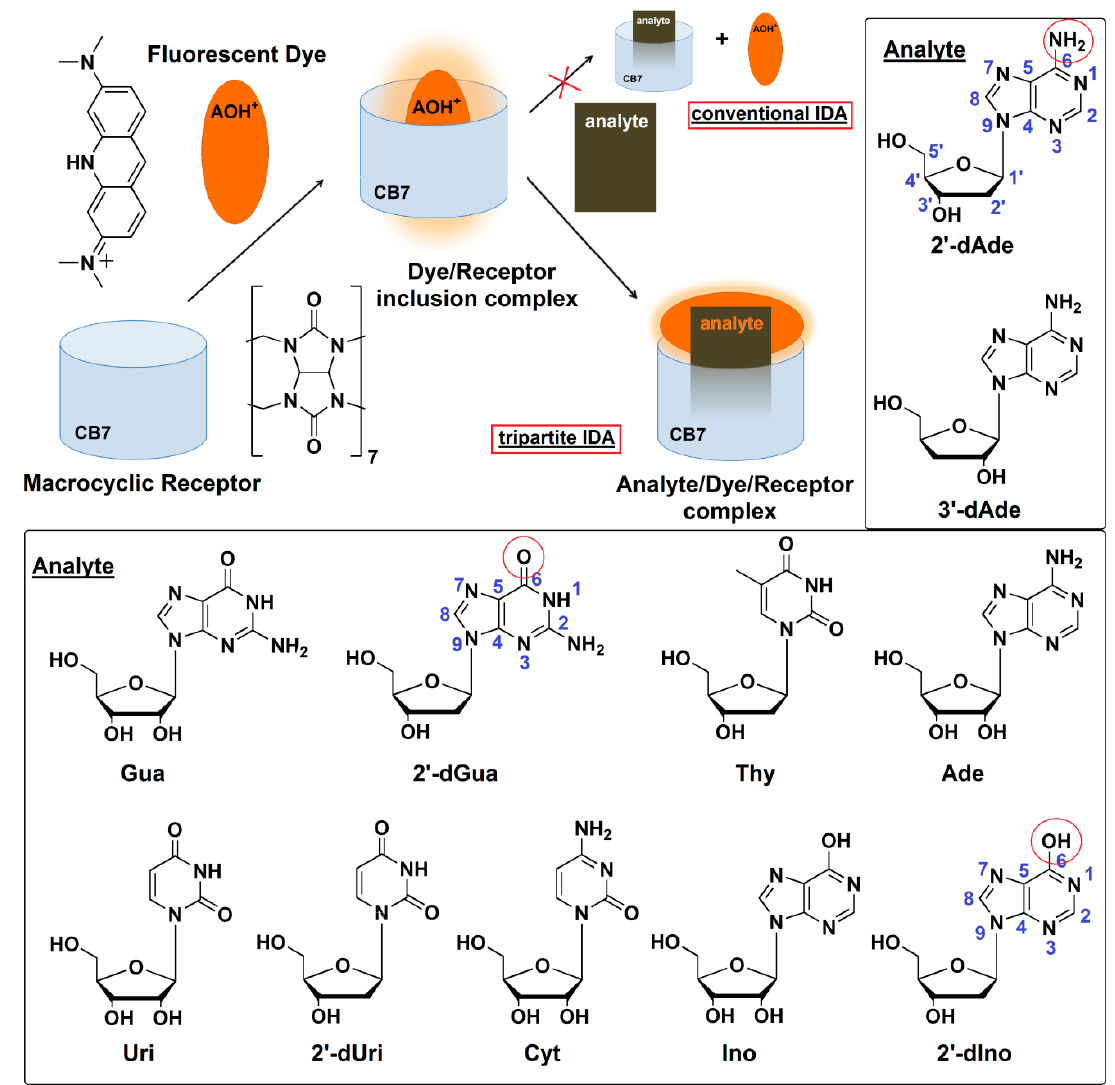
Figure 1. Proposed mechanism of a newly developed tripartite IDA strategy using protonated acridine orange (AOH + ) and cucurbit[7]uril (CB7) based on the transformation from inclusion to Exo complex of AOH + for detection of bioactive nucleosides found in Cordyceps spp. Ade: adenosine, 2 (cid:48) -dAde: 2 (cid:48) -deoxyadenosine, 3 (cid:48) -dAde: 3 (cid:48) -deoxyadenosine or cordycepin, Ino: inosine, 2 (cid:48) -dIno: 2 (cid:48) -deoxyinosine, Gua: guanosine, 2 (cid:48) -dGua: 2 (cid:48) -deoxyguanosine, Uri: uridine, 2 (cid:48) -dUri: 2 (cid:48) -deoxyuridine, Cyt: cytidine, Thy: thymidine.